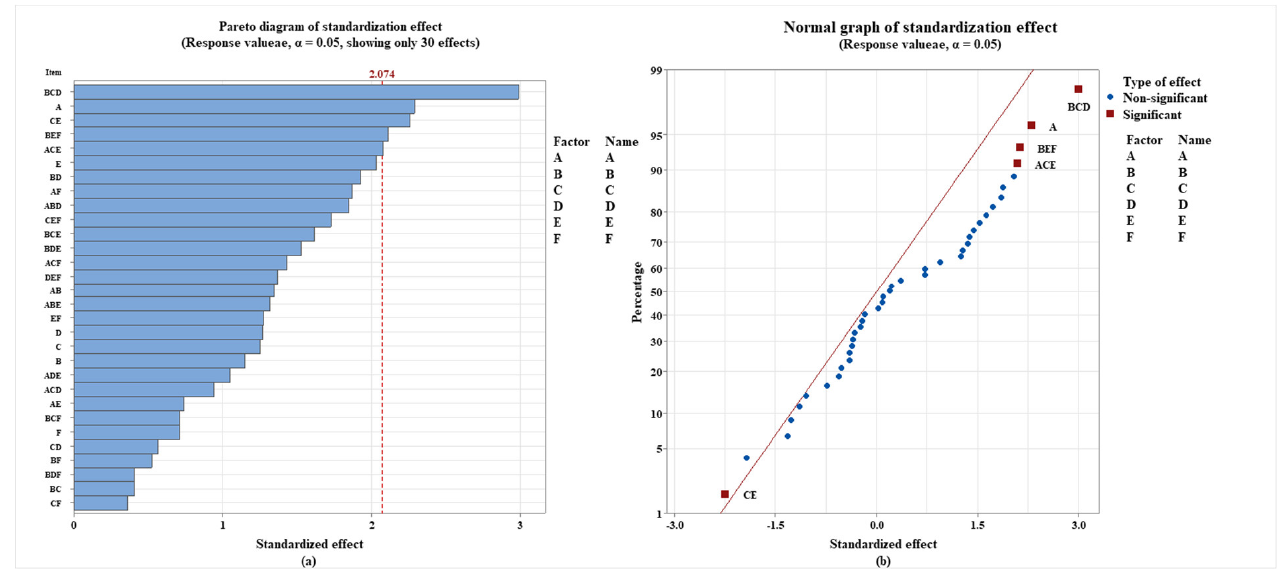
Figure 4. Analysis of the degree of main effect and interaction effect of plastic additives on polystyrene 5 polymer biodegradation (Pareto Diagram of standardization effect ( a ), normal diagram of standardization effect ( b )).